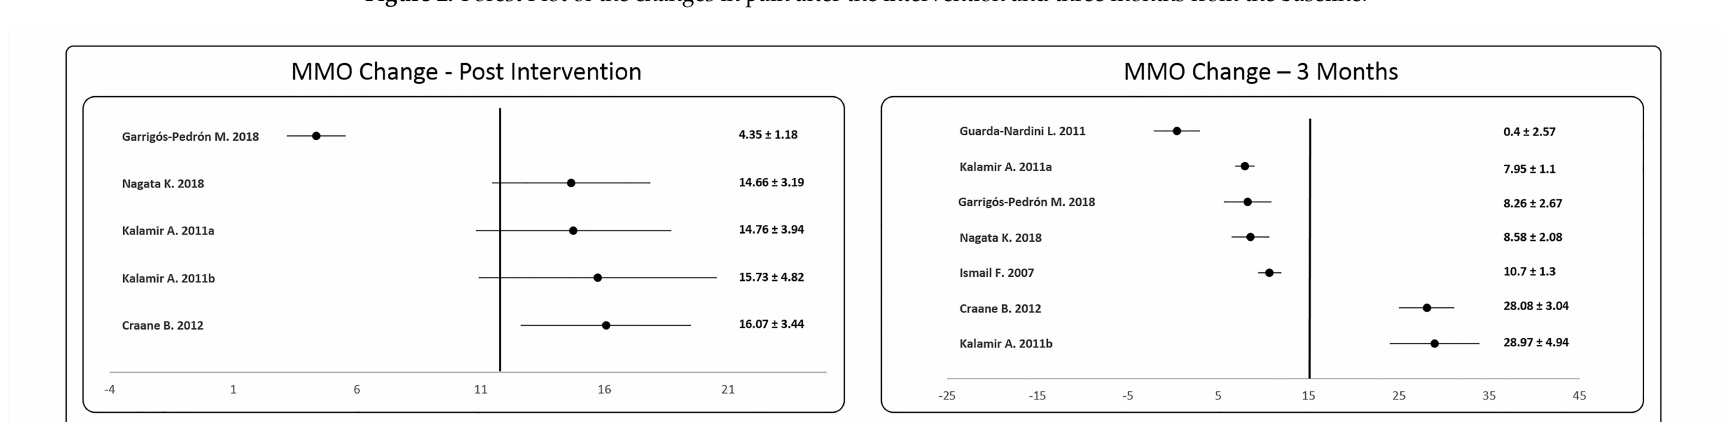
Figure 2. Forest Plot of the changes in pain after the intervention and three months from the baseline.